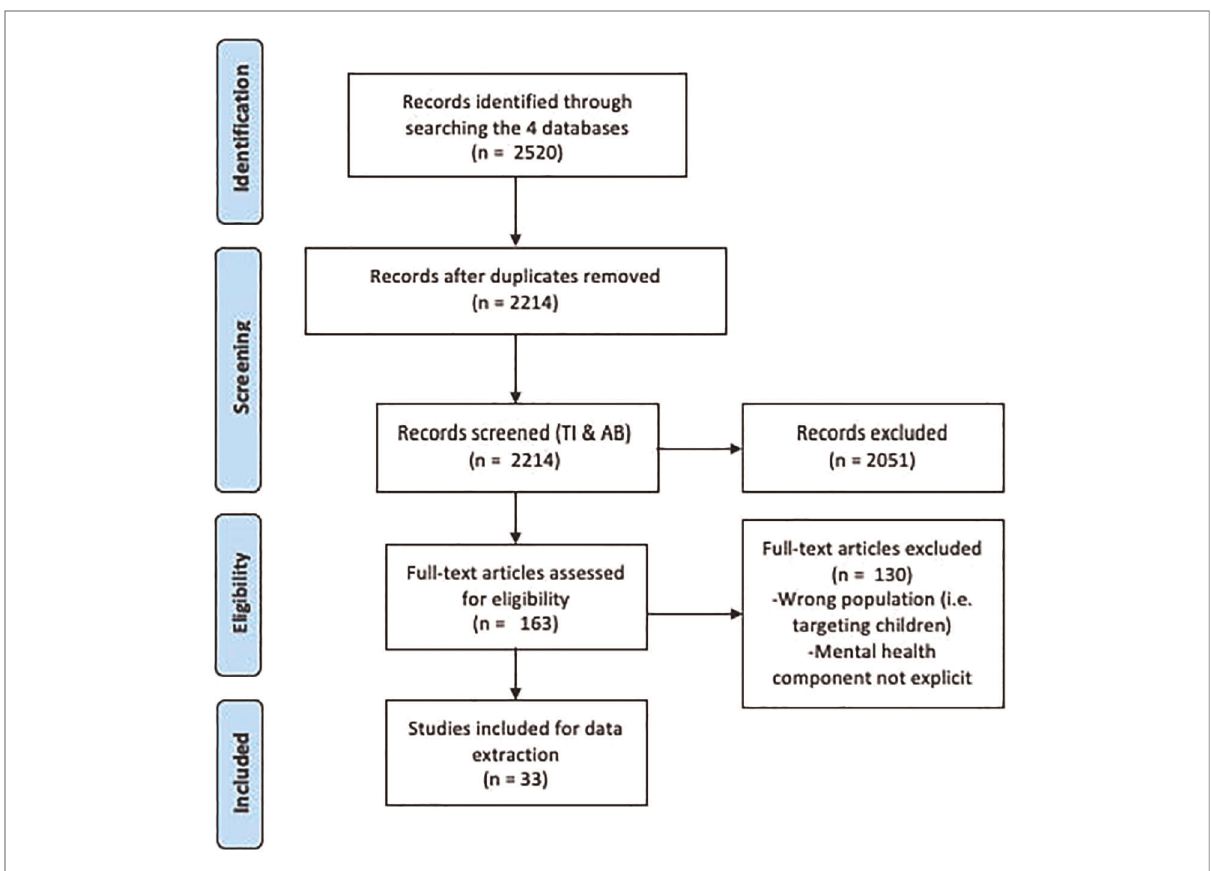
FIGURE 1 PRISMA fl ow diagram.